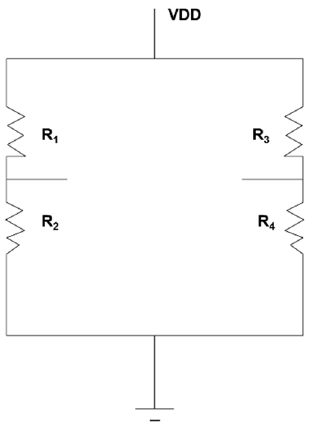
Figure 7. Wheatstone bridge for connecting the piezoresistors.